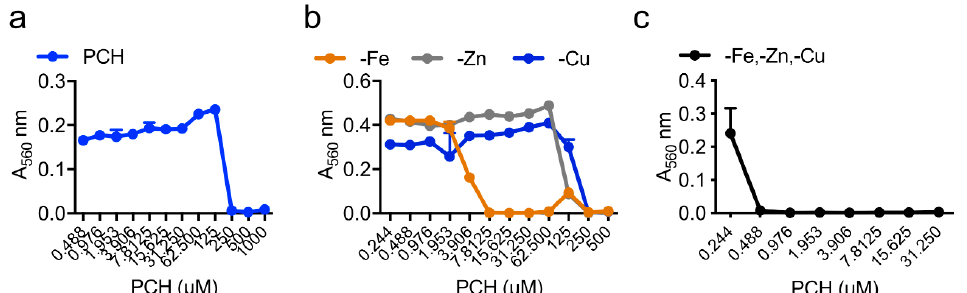
Figure 2. Pyochelin (PCH) antifungal activity on A. fumigatus . Growth was measured by the absorbance of the crystal violet-binding hyphae at 560 nm. ( a ) In minimal medium (MM); ( b ) In MM depleted in iron (-Fe), Zinc (-Zn) or copper (-Cu); ( c ) In MM depleted in iron, zinc and copper (-Fe,-Zn,-Cu). Medium composition and methodology are described in Supplementary Materials.